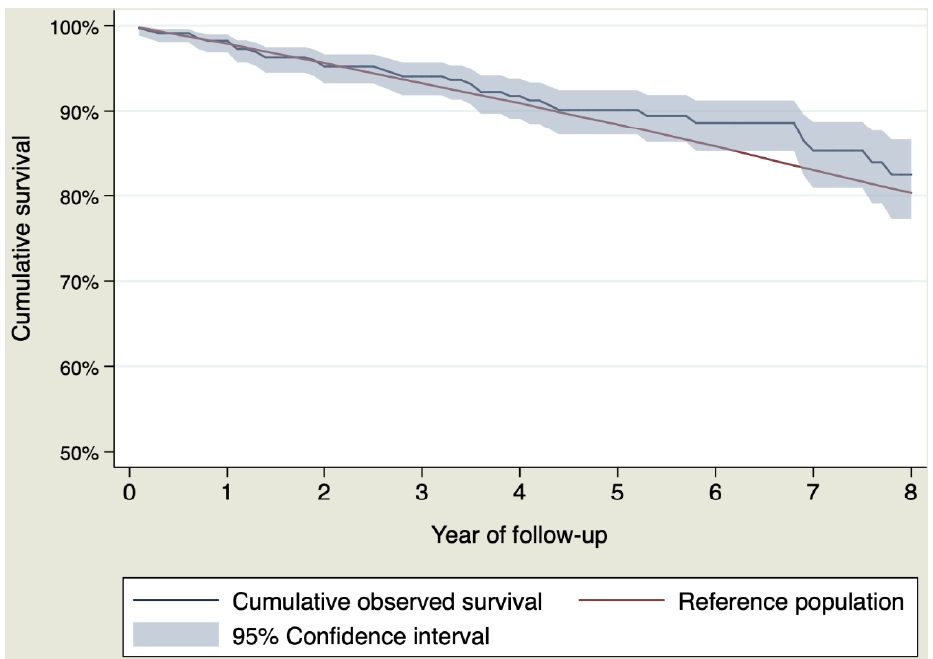
Figure 3. Observed and expected survival for patients who survived the postoperative period.